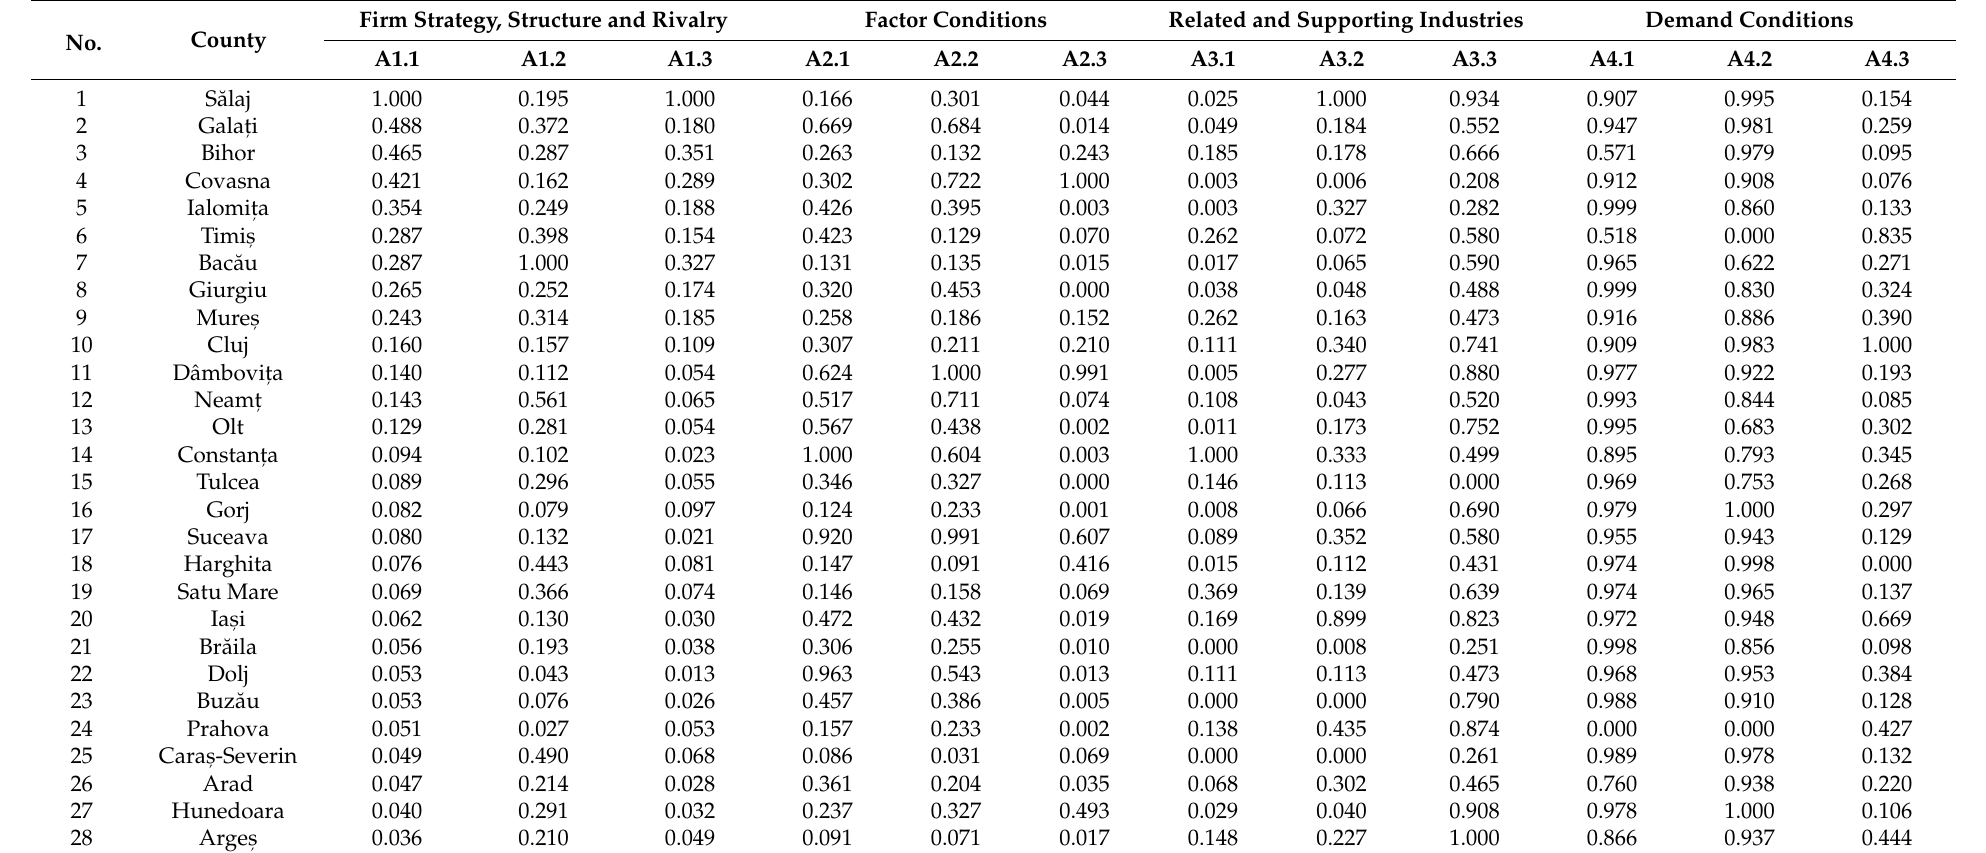
Table 8. Porter’s diamond model attributes and variable coefficients at county level. Source: authors’ own